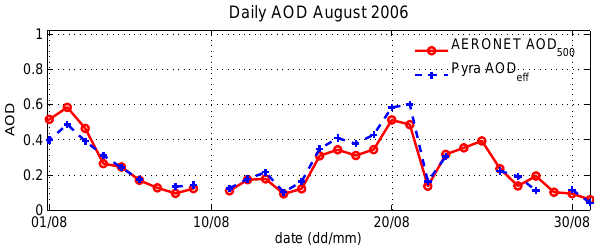
Fig. 4. Time series of daily averaged pyranometer-based AOD eff and AERONET AOD 500 for August